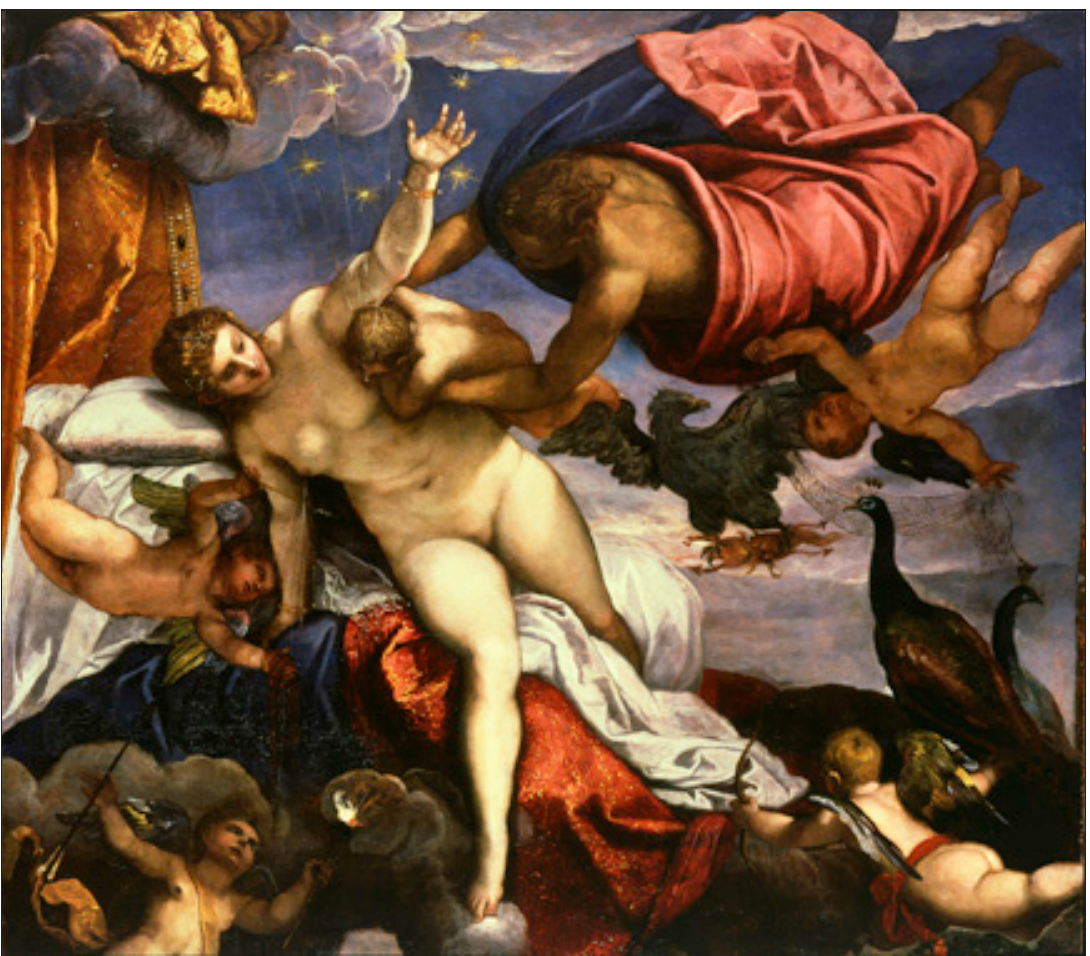
Figure 6: Jacopo Tintoretto, The Origin of the Milky Way, ca. 1575, oil on canvas, 149.4 × 168 cm. © National Gallery,